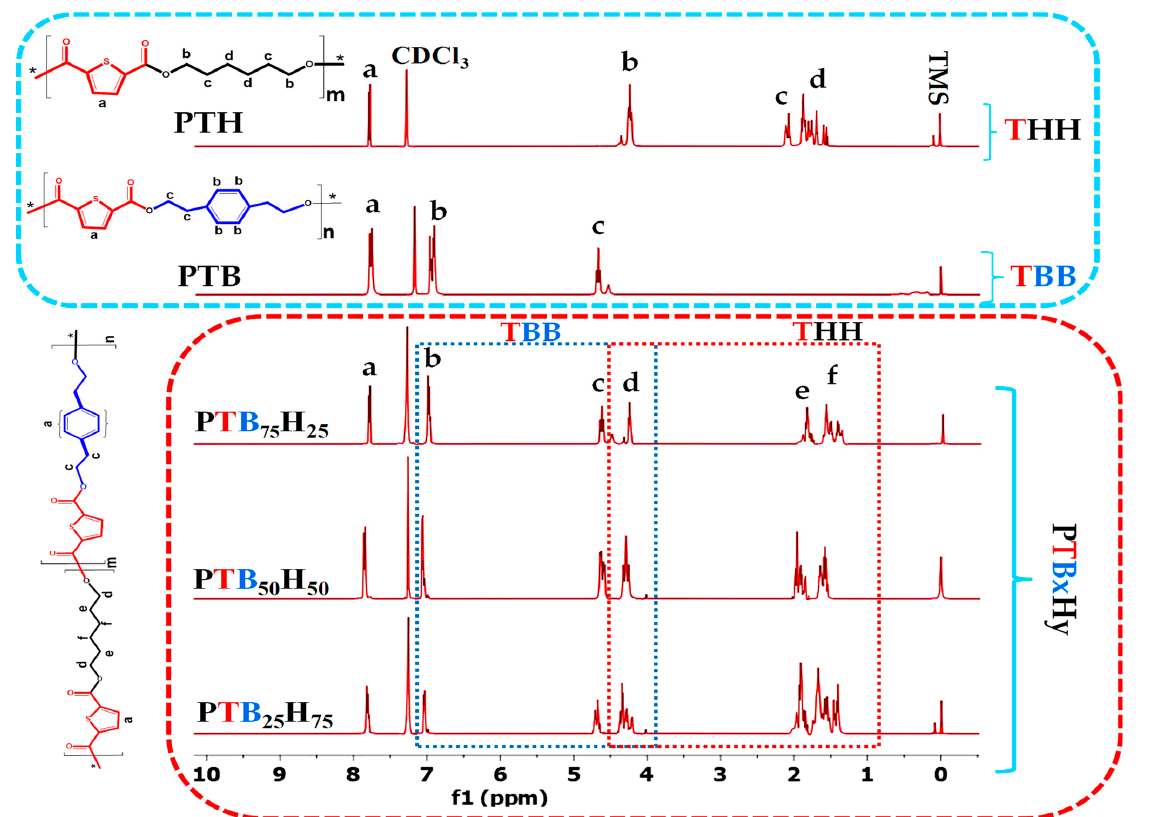
Figure 2. 1 H NMR spectra of poly(1,4-bis(2-hydroxyethyl)benzene thiophenedicarboxylate) (PTBB), poly(hexylene thiophenedicarboxylate) (PTHH), and poly(hexylene 2,5-thiophenedicarboxylate-co- bis(2-hydroxyethoxybenzene) (PTB x H y ) copolyesters.